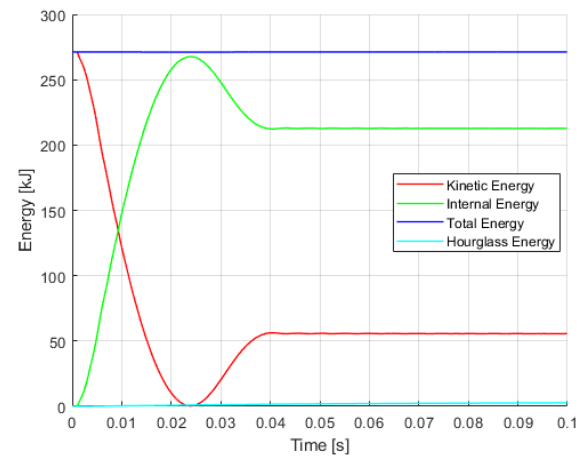
Figure 10. Energy curves.